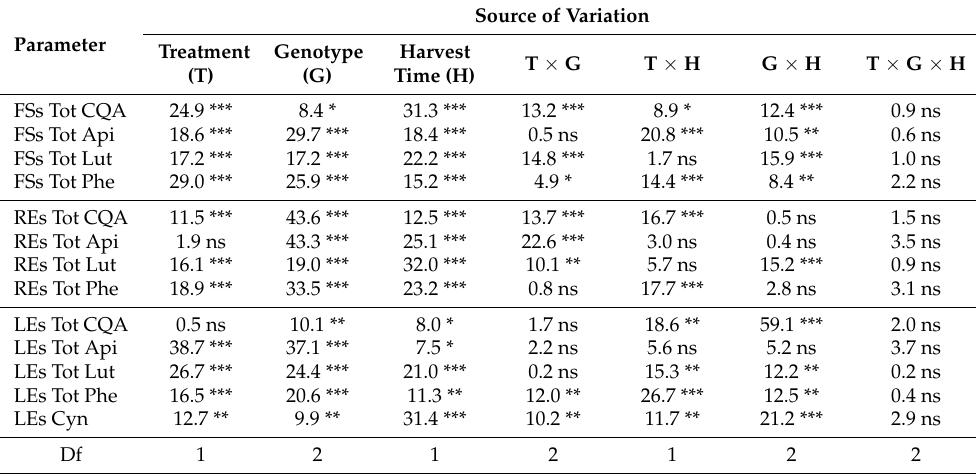
Table 1. Mean square per each source of variation (percentage of total) resulting from analysis of variance for the content of total caffeoylquinic acid (Tot CQA), total apigenin (Tot Api), total luteolin (Tot Lut), total measured polyphenol (Tot Phe), and cynaropicrin (Cyn) in the floral stems (FSs), receptacles (REs) and leaves (LEs) of the globe artichokes.